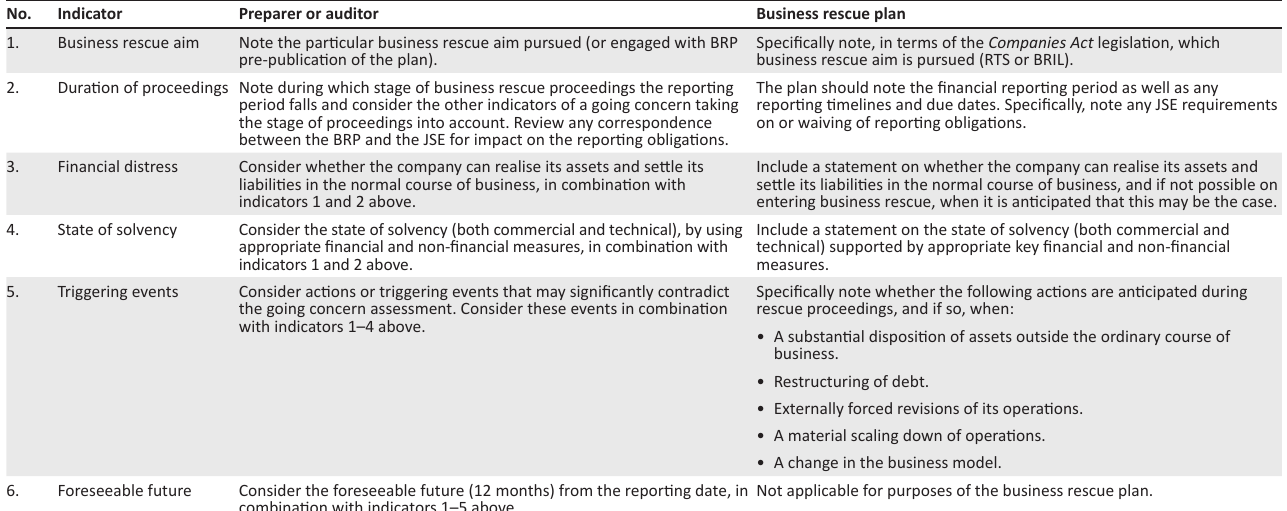
TABLE 3: Recommended going concern indicators for consideration by the preparer or the auditor and information to be included in the business rescue plan. No.